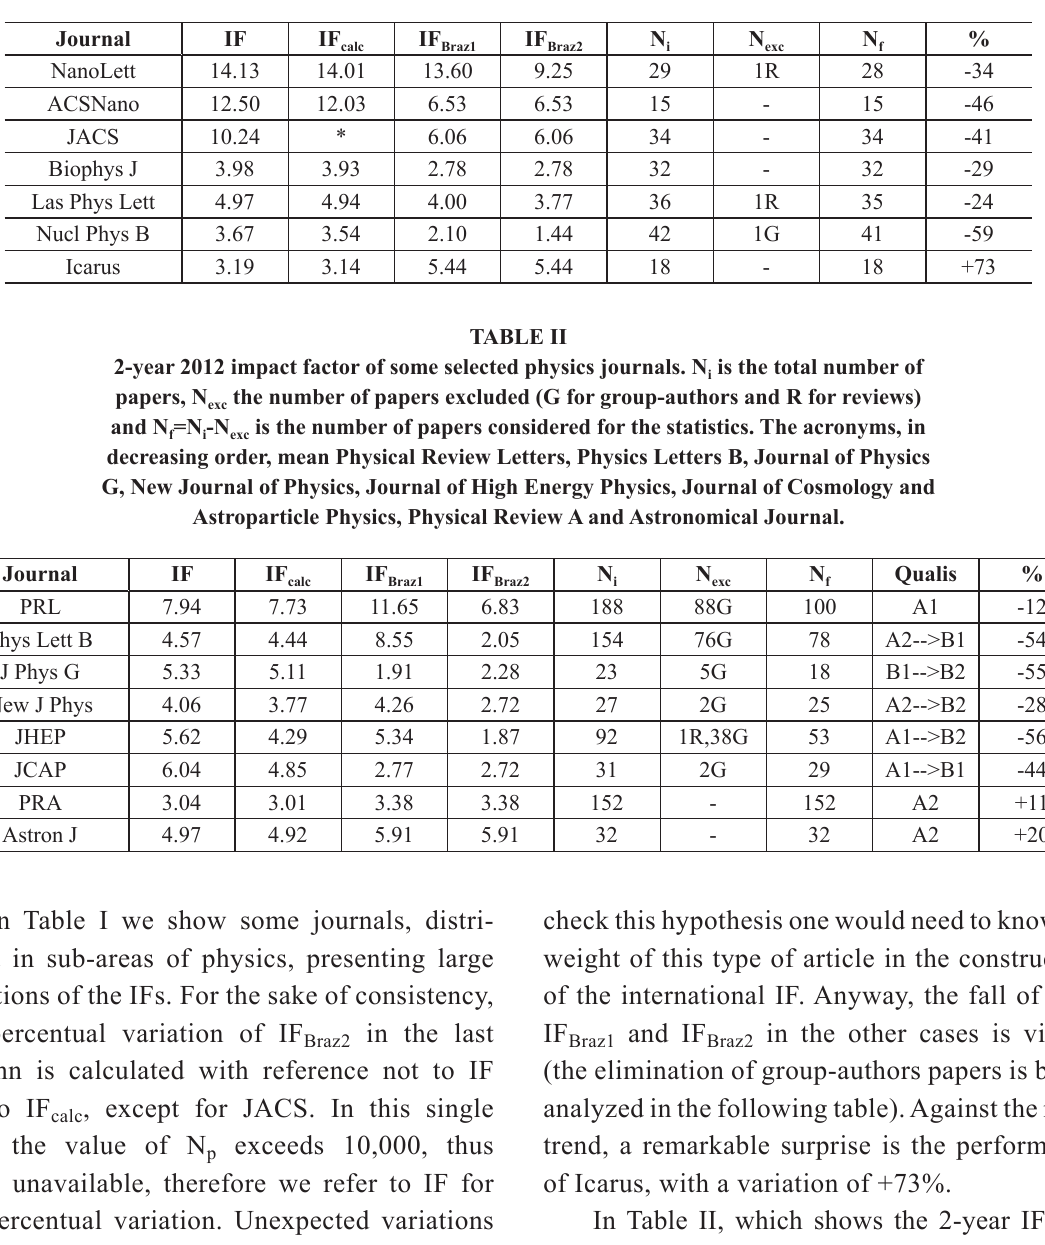
5-year 2012 impact factor of some selected physics journals. N N the number of papers excluded (G for group-authors and R for reviews) and N exc the number of papers considered for the statistics. The acronyms, in decreasing order, mean Nano Letters, ACS Nano, Journal of the American Chemistry Society, Biophysical Journal,